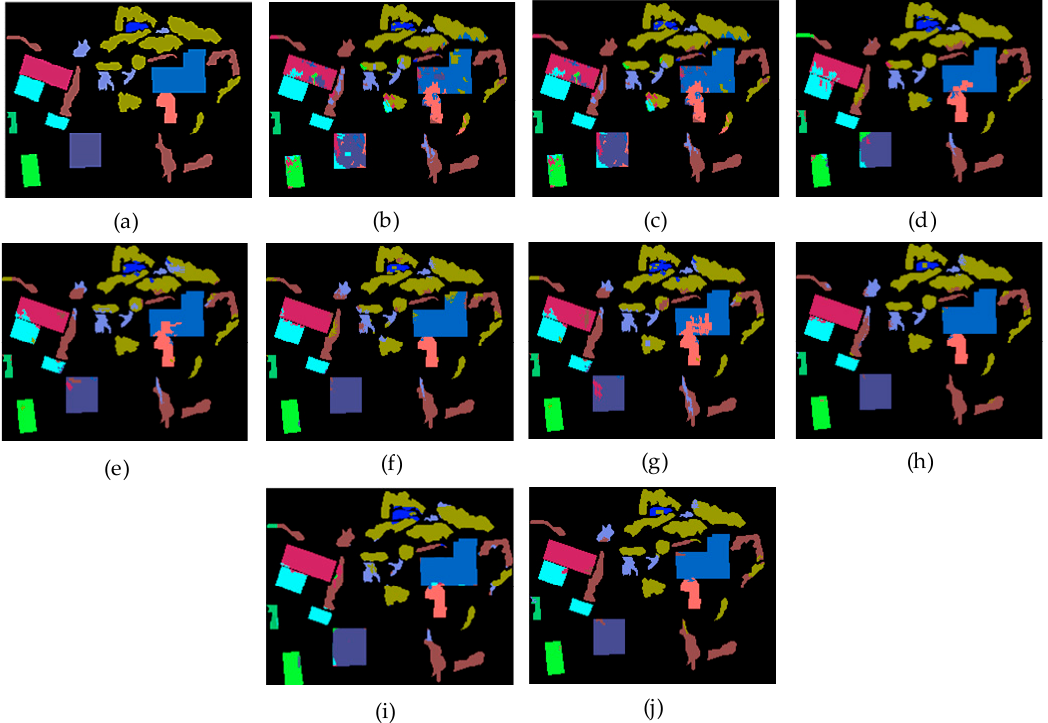
Figure 11. Classification results on Recology data set: ( a ) Ground-truth map; ( b ) Decision Tree; ( c ) SVM; ( d ) KNN; ( e ) Random Forest; ( f ) CNN; ( g ) CapsNet; ( h ) ResNet; ( i ) OctSqueezeNet; ( j ) ResCapNet.